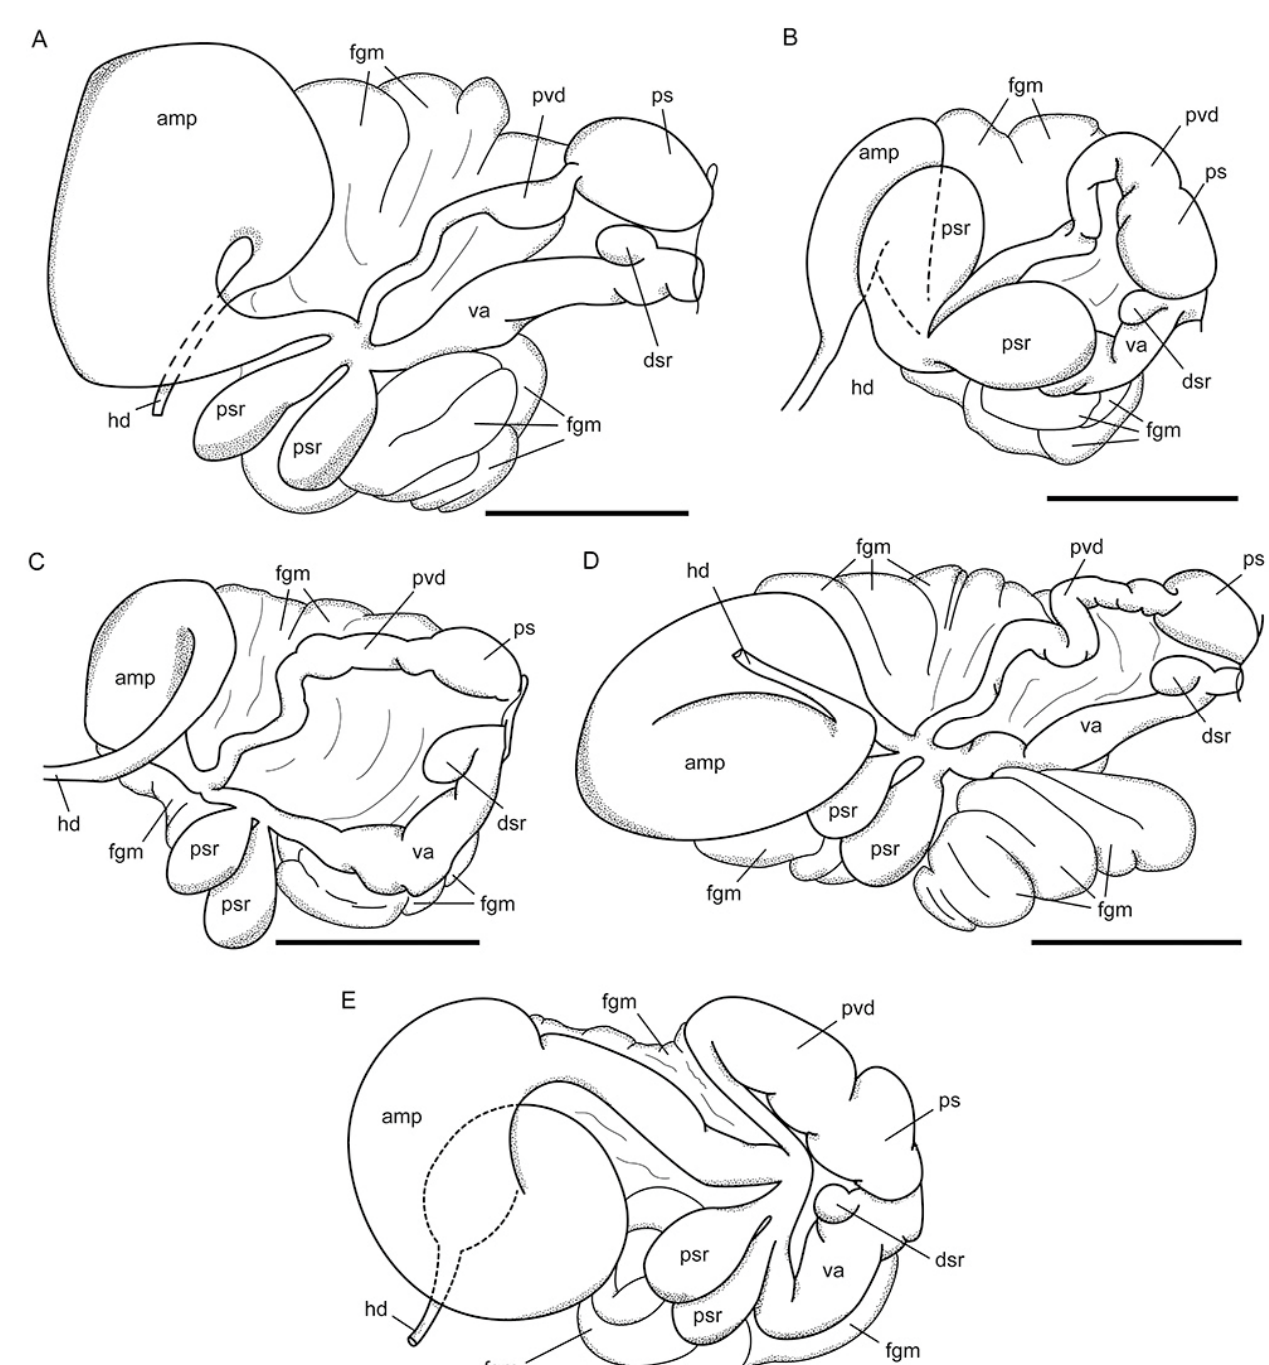
Figure 7. The reproductive system morphology in Coryphellina rubrolineata species complex.